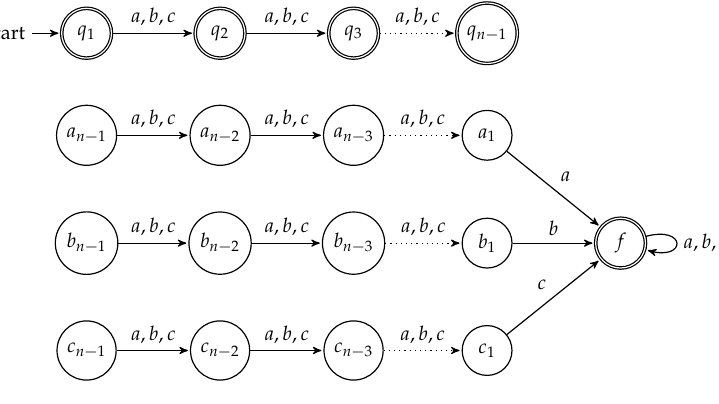
Figure 1. A sketch of the NFA construction of Theorem